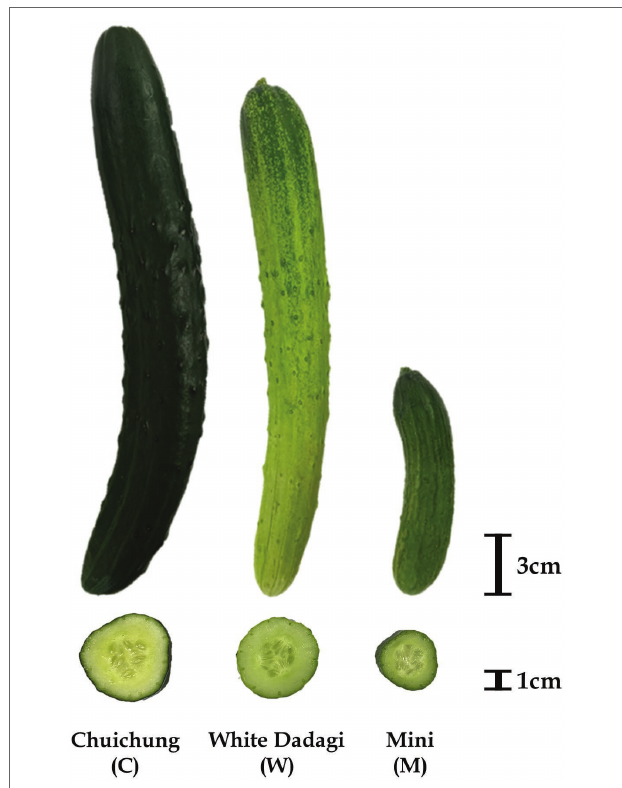
FIGURE 1 | Photographs of representative ripe fruit of the three cucumber cultivars evaluated in this study: Chuichung, White Dadagi, and